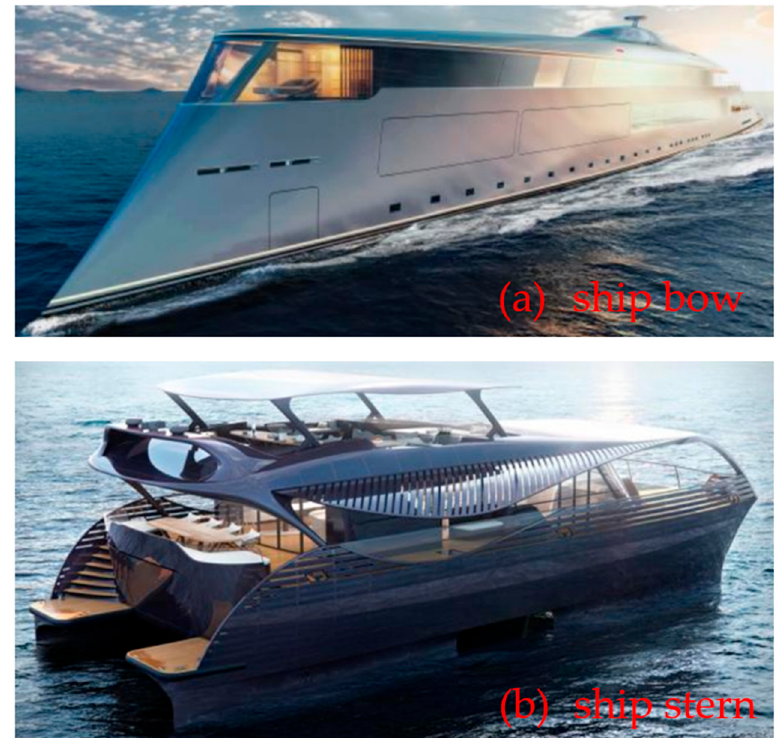
Figure 24. The conceptual design of a super-premium yacht, “Aqua” [115].